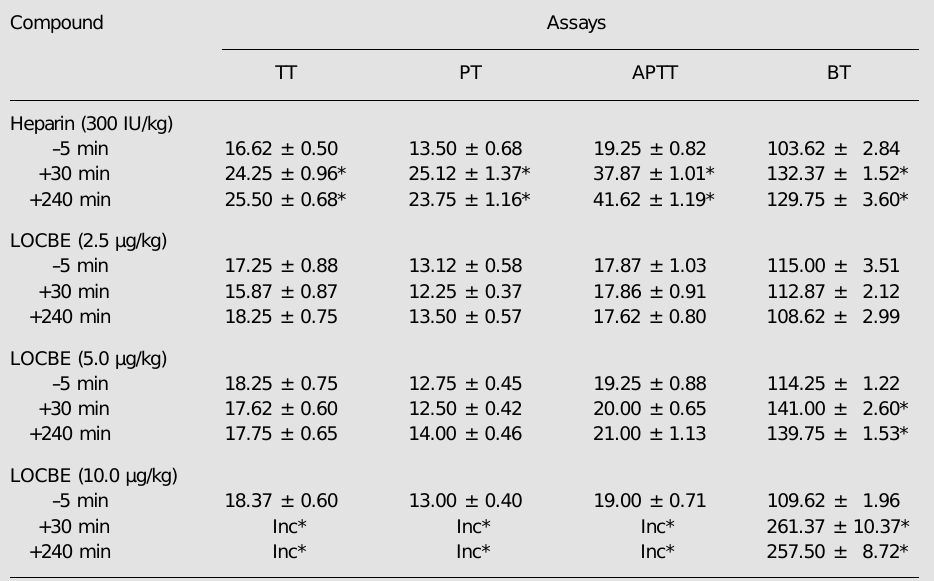
Table 2. Effects of heparin and Lonomia obliqua caterpillar bristle extract (LOCBE) infusion on the coagulation parameters of rats. Compound